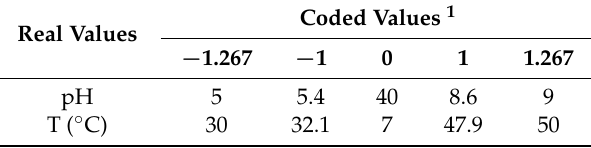
Table 1. Real and coded values of independent variables in the factorial design 2 2 -central composite. Real